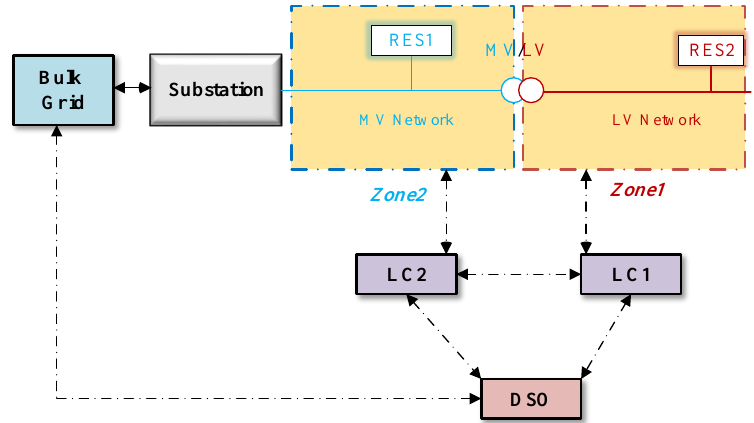
Figure 4. A typical distribution network with the proposed framework.